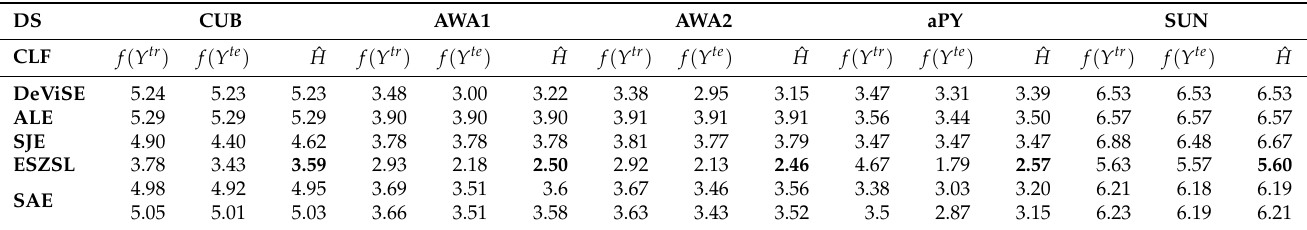
Table 6. Individual Classifier Results for the LogLoss Accuracy.